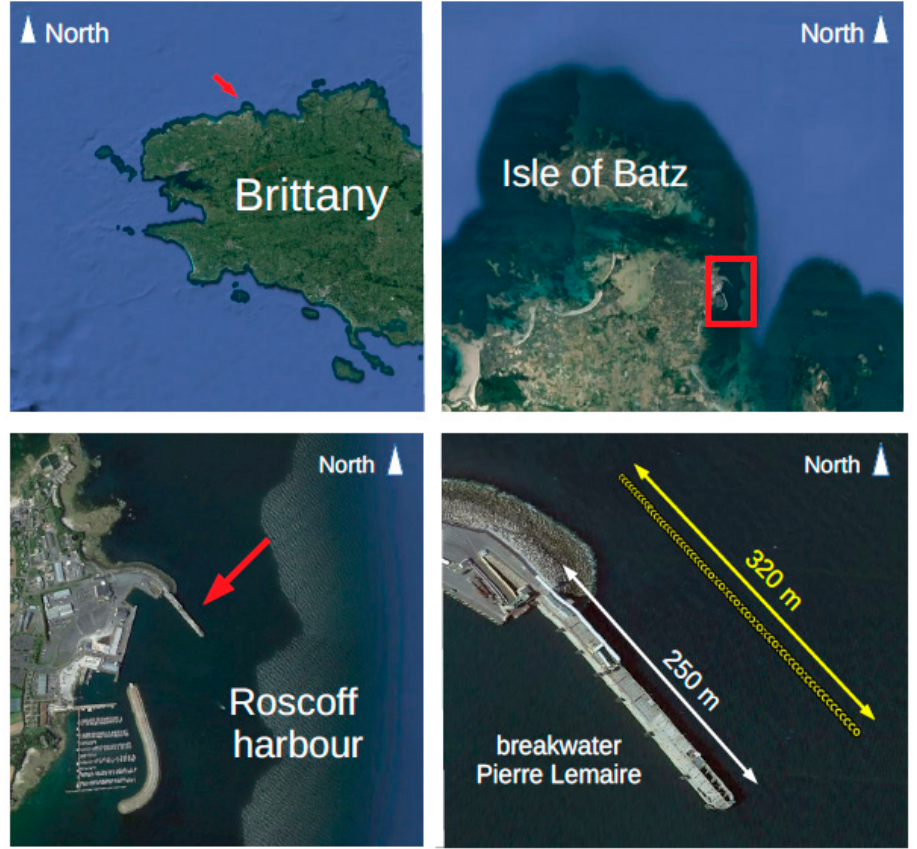
Figure 1. Google Earth maps showing the location of the harbour of Roscoff in western Brittany (France) with a detailed view of the surroundings of the breakwater “Pierre Lemaire”. The yellow circles are displayed along a line considered offshore from this infrastructure; the line is used as reference for the extraction of SWAN hindcast predictions.